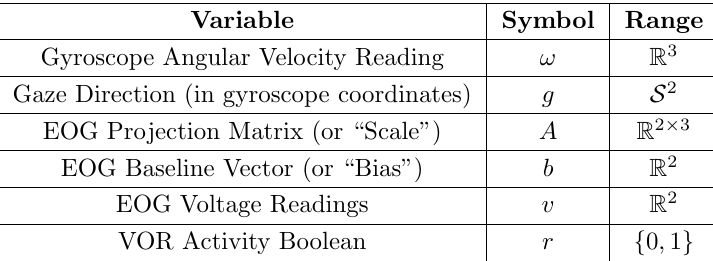
Table 1: Modeled random variables. Each is a function of time and the underlying probability space. The unit-sphere S 2 is represented as { g ∈ R 3 | ⟨ g, g ⟩ = 1 } . I.e., gaze is handled as a 3D direction vector rather than a pair of angles. When the wearer’s VOR is engaged, r is 1, else it is